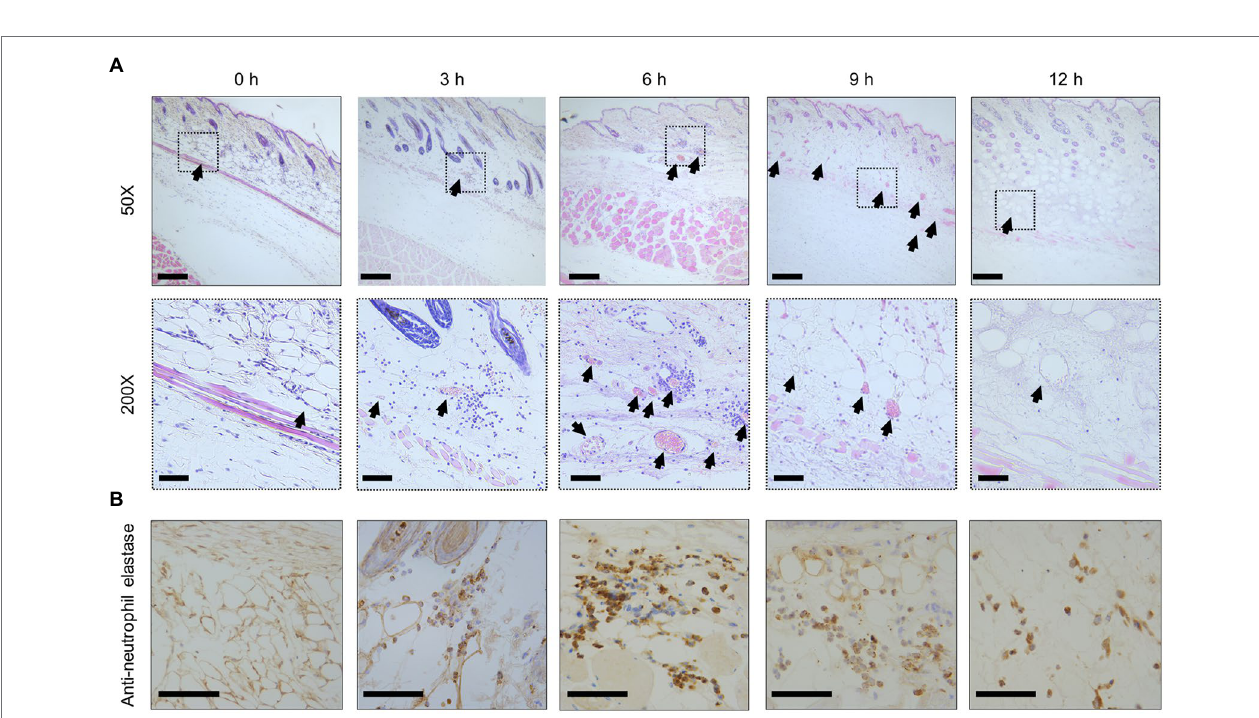
FIGURE 3 | Congestion and inflammation in the skin. (A) Hematoxylin–eosin-stained histopathology images at the subcutaneous inoculation site in a mouse infected with Vibrio vulnificus (10 6 CFU/mouse). Lower panels show a high-power field of the part enclosed in upper panels. Arrowheads indicate blood vessels in the subcutaneous tissue. Scale bars: 100 μ m (upper panels) and 25 μ m (lower panels). (B) The immunostained-histopathology images with anti-neutrophil elastase antibody at the subcutaneous inoculation site in a mouse infected with V. vulnificus (10 6 CFU/mouse). Scale bars: 25 μ